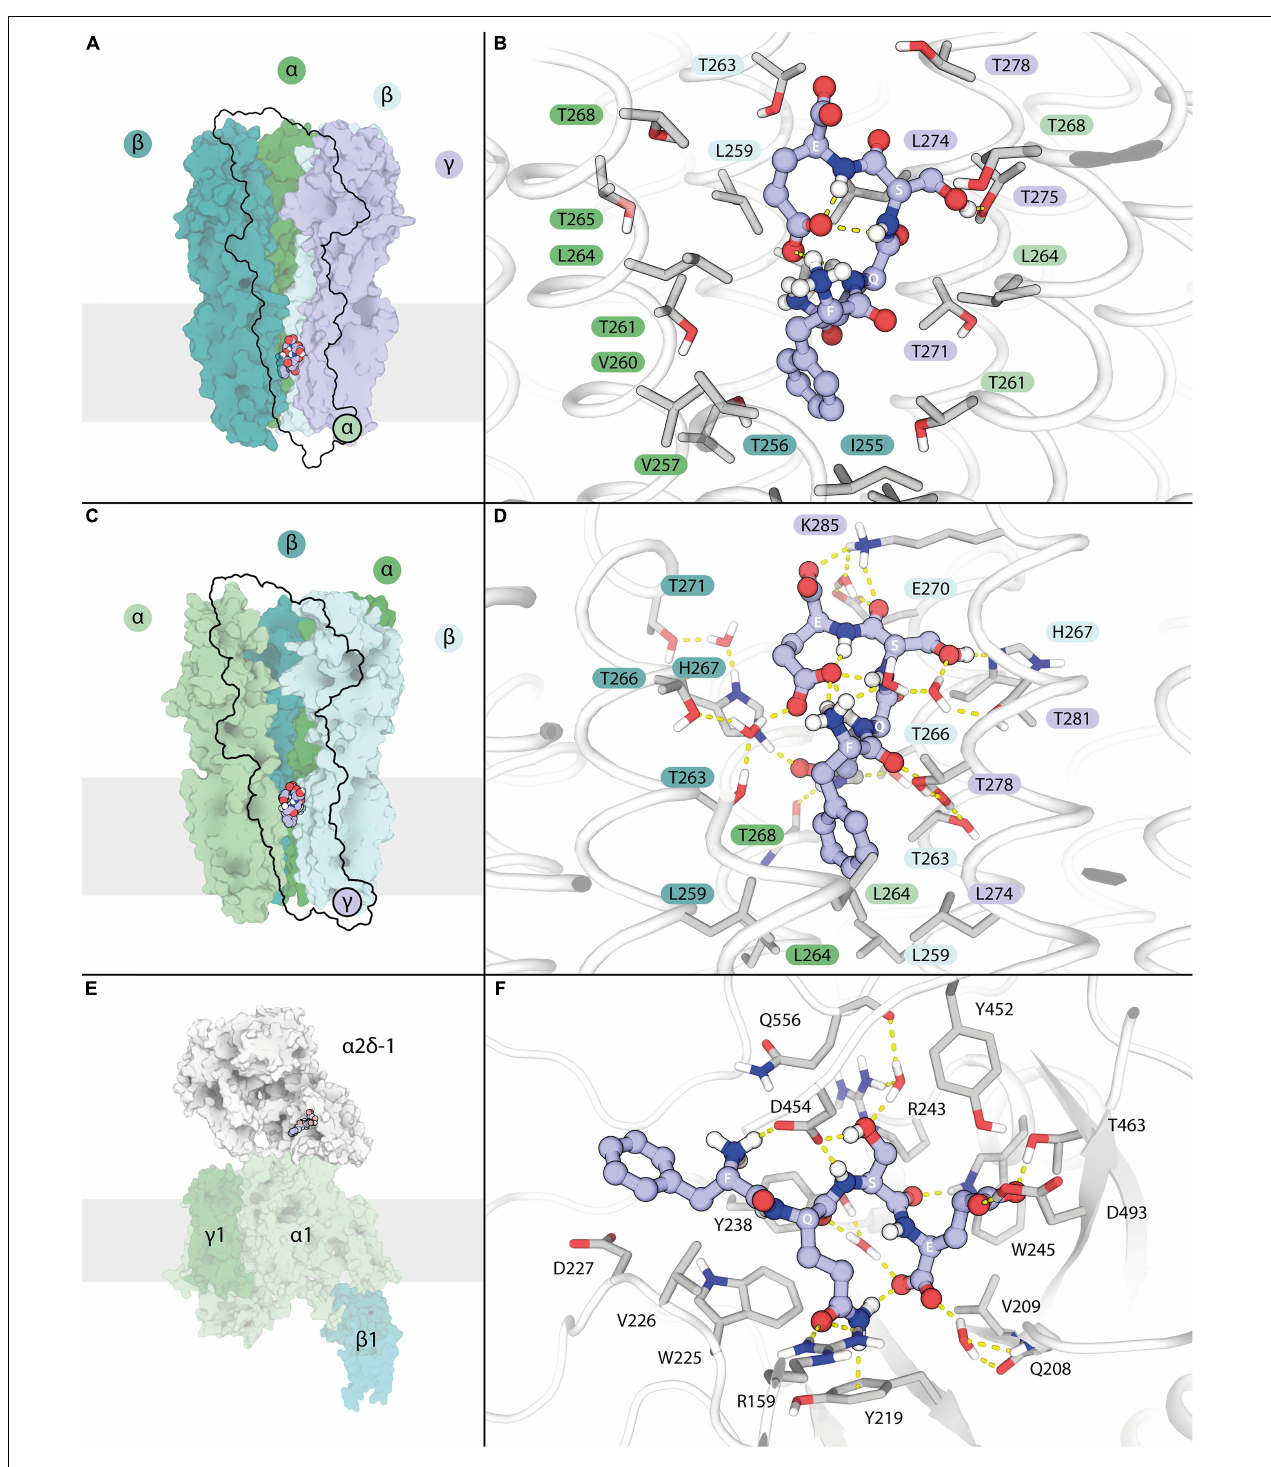
FIGURE 1 | Interactions of LCGA-17 with GABA A receptors and α 2 δ of VGCCs revealed by modeling of binding poses. (A) Low magnification view of a “wide-lumen” α 1 β 2 γ 2 GABA A R with bound LCGA-17 peptide depicted in spheres. The proximal α 1 subunit is omitted for clarity. (B) Major interactions of LCGA-17 with its lower GABA A R transmembrane binding site. (C) Low magnification view of a “narrow-lumen” α 1 β 2 γ 2 GABA A R with bound LCGA-17. The γ 2 subunit is omitted for clarity. (D) Major interactions of LCGA-17 in the upper GABA A R transmembrane binding pocket. The colors of amino acid labels match the color code of subunits in panels (A,C) . (E) Overview of VGCC with LCGA-17 bound to the α 2 δ -1 subunit binding pocket. (F) Major interactions of LCGA-17 within the α 2 δ -1 binding pocket. Note that non-polar hydrogen atoms are omitted for clarity in all images. Hydrogen bonds are shown as dashed lines. Carbon atoms of LCGA-17 are shown in purple and gray, oxygen in red; nitrogen in